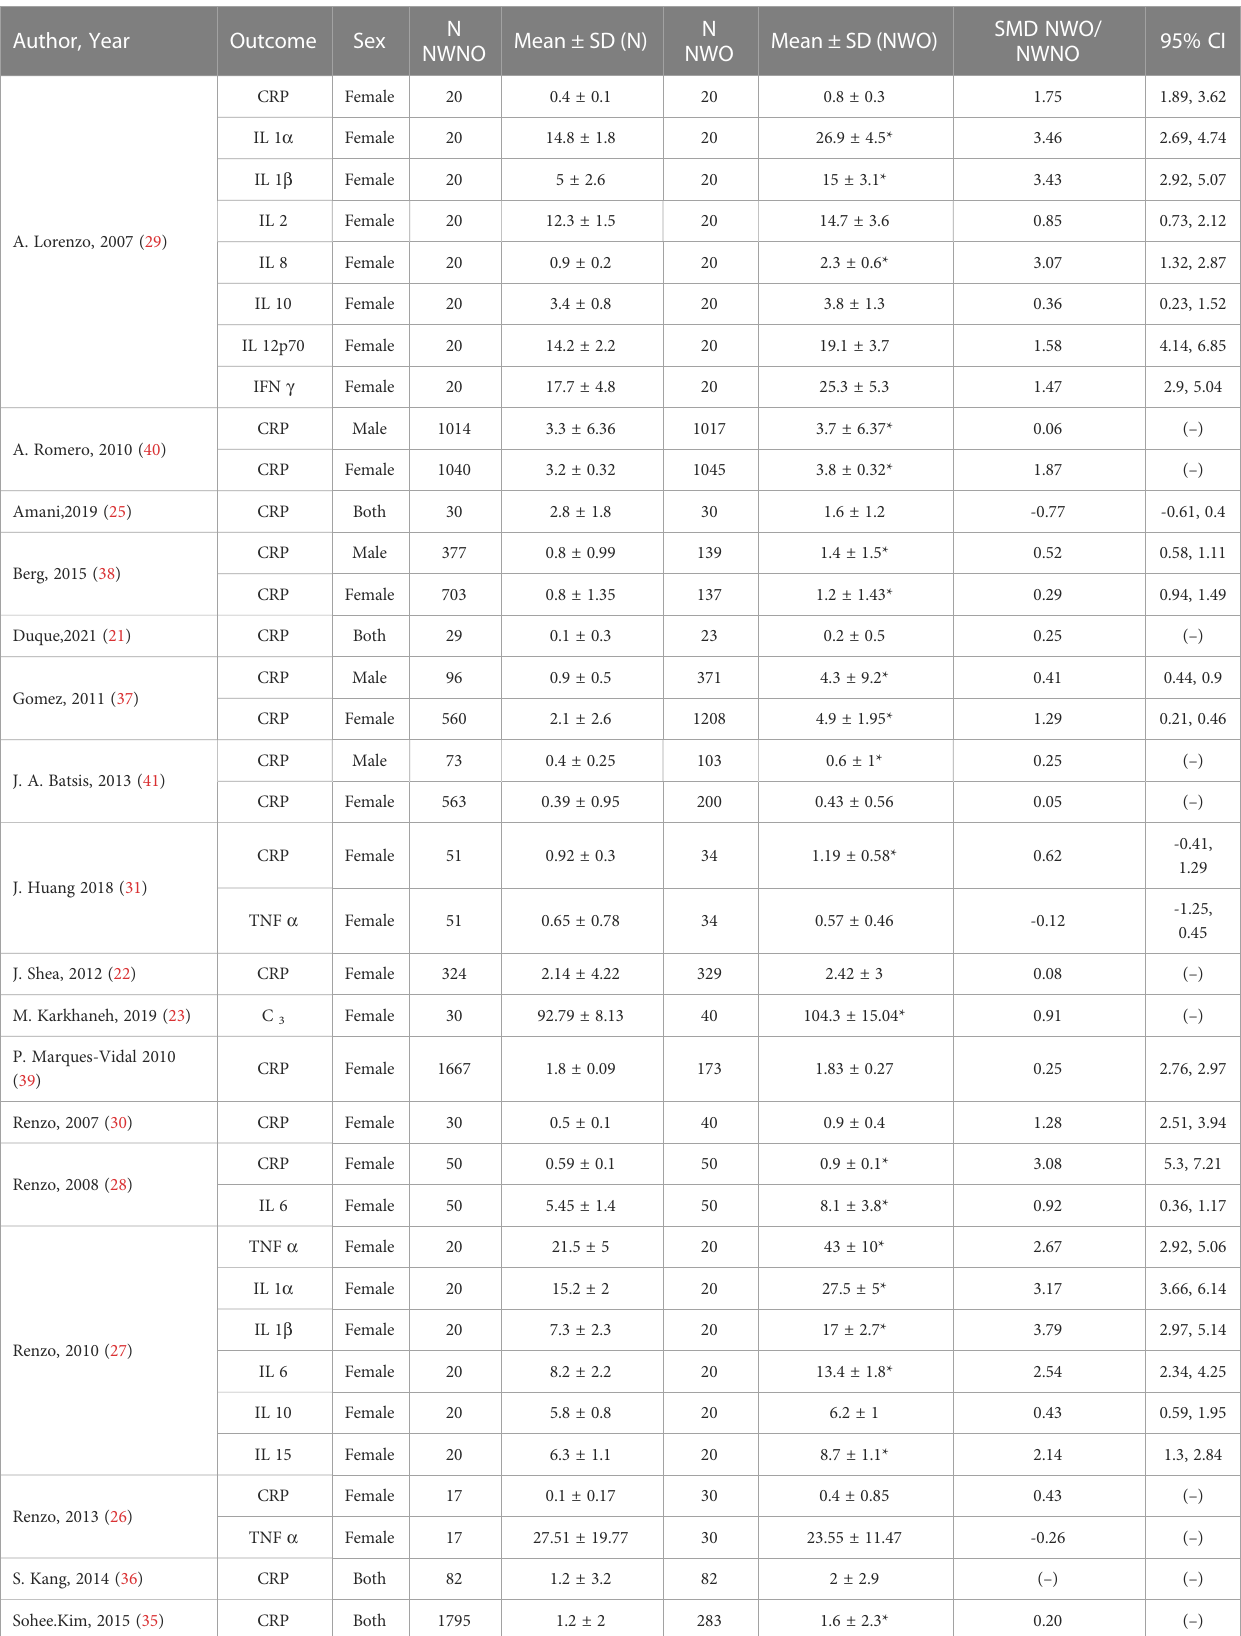
TABLE 2 Association of NWO with the mean of in fl ammatory markers in included studies.